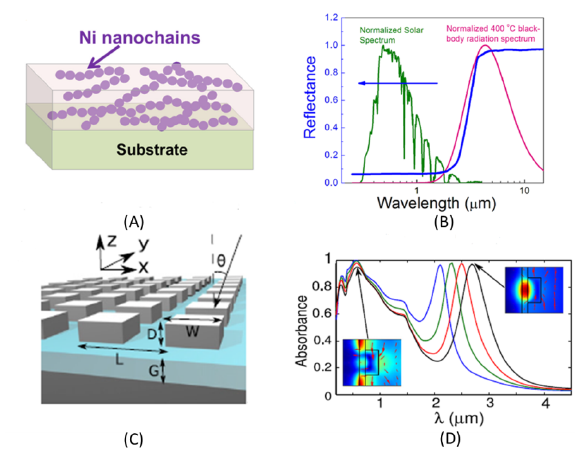
Fig. 5. Should be: Plasmonic selective solar absorbers. (A) A schematic drawing of the selective absorber with Ni nanochains embedded in Al 2 O 3 . (B) Reflectance spectrum of the selective ab- sorber with Ni nanochains embedded in Al 2 O 3 (blue line) shows high selectivity to avoid thermal reradiation when operating at a temperature of 673 K. Panels (A) and (B) adapted with permission from [51]. © 2012, AIP Publishing LLC. (C) Schematic drawing of the 2D planar plasmonic integrated absorber/emitter. (D) Simulated absorbance spectrum of the integrated absorber/emitter. High- energy absorption peak and low-energy absorption peak for solar irradiance absorption and thermal emission, respectively. The low- energy absorption peak can be tuned by the dimensions of the pat- terning feature. Peak from left to right corresponds to L = 383 nm; W = 206 nm; D = 83 nm; G = 27 nm/ L = 393 nm; W = 230 nm; D = 79 nm; G = 24 nm/ L = 404 nm; W = 252 nm; D = 73 nm; G = 23 nm/ L = 396 nm; W = 269 nm; D = 72 nm; G = 22 nm. Panels (A) and (B) adapted with permission from [52]. © 2012 IOP Publish- ing. All rights